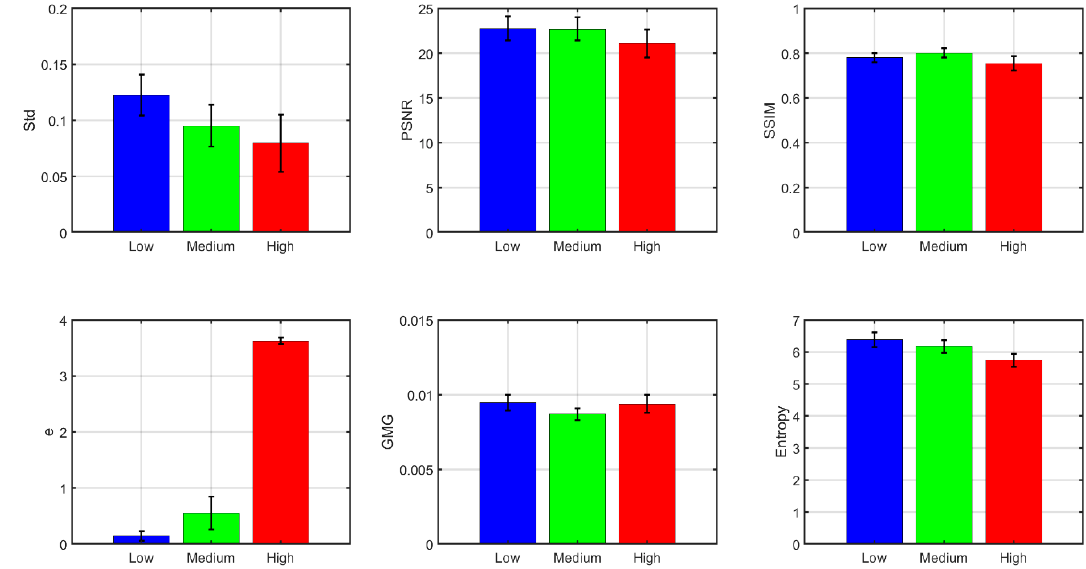
Figure 6. Quality metrics for the dehazed images (average of all wavelengths above 550 nm and the five algorithms tested). Standard deviations are indicated as error bars in the figure.